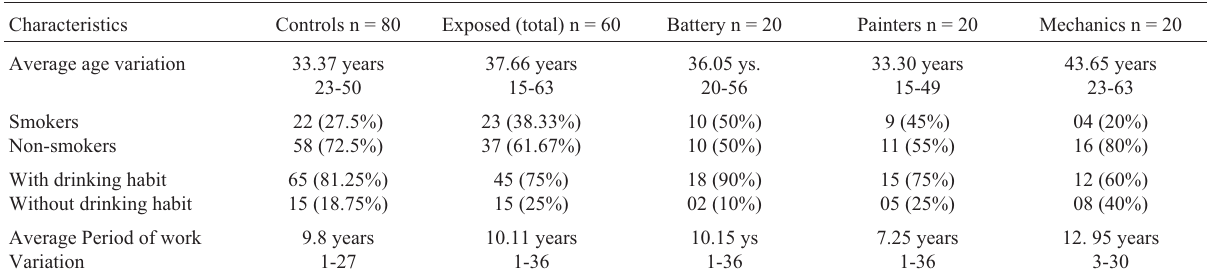
TableI -Characterizationofgroupsandsubgroupsofindividuals,exposedandnon-exposedtobyproductsofpetrolandlead,whotookpartinthestudy. Characteristics